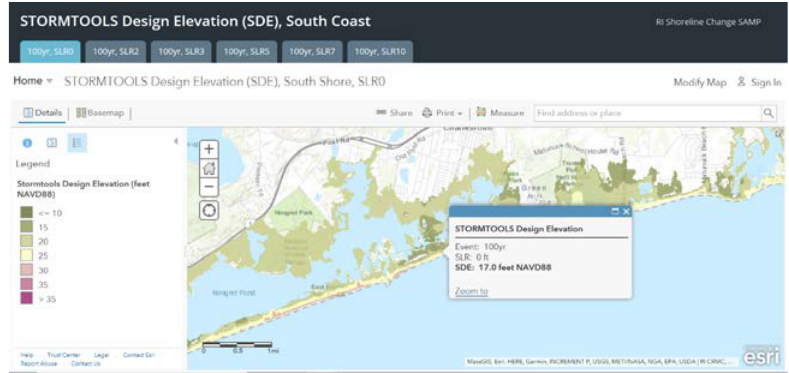
Figure 8. Flooding in Charlestown, RI, (see green oval in Figure 2) in the vicinity of Ninigret and Green Hill Ponds for 100-yr, no-SLR case. The insert shows the ability of the point interrogation tool to determine the BFE at the user location selected.